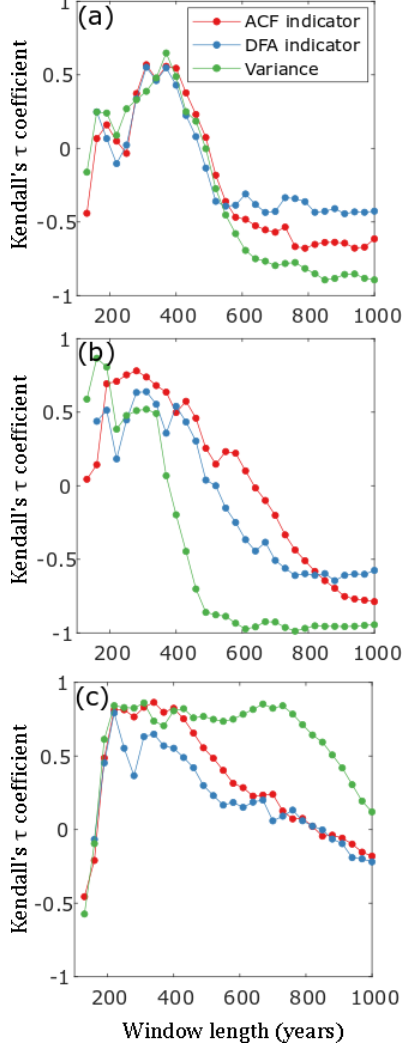
Figure 7. The effect of window length on the predictive power of EWIs for MISI. The three panels show the change in Kendall’s τ coefficient as calculated for each indicator versus window length for MISI events 1, 2 and 3 (panels a , b and c ,